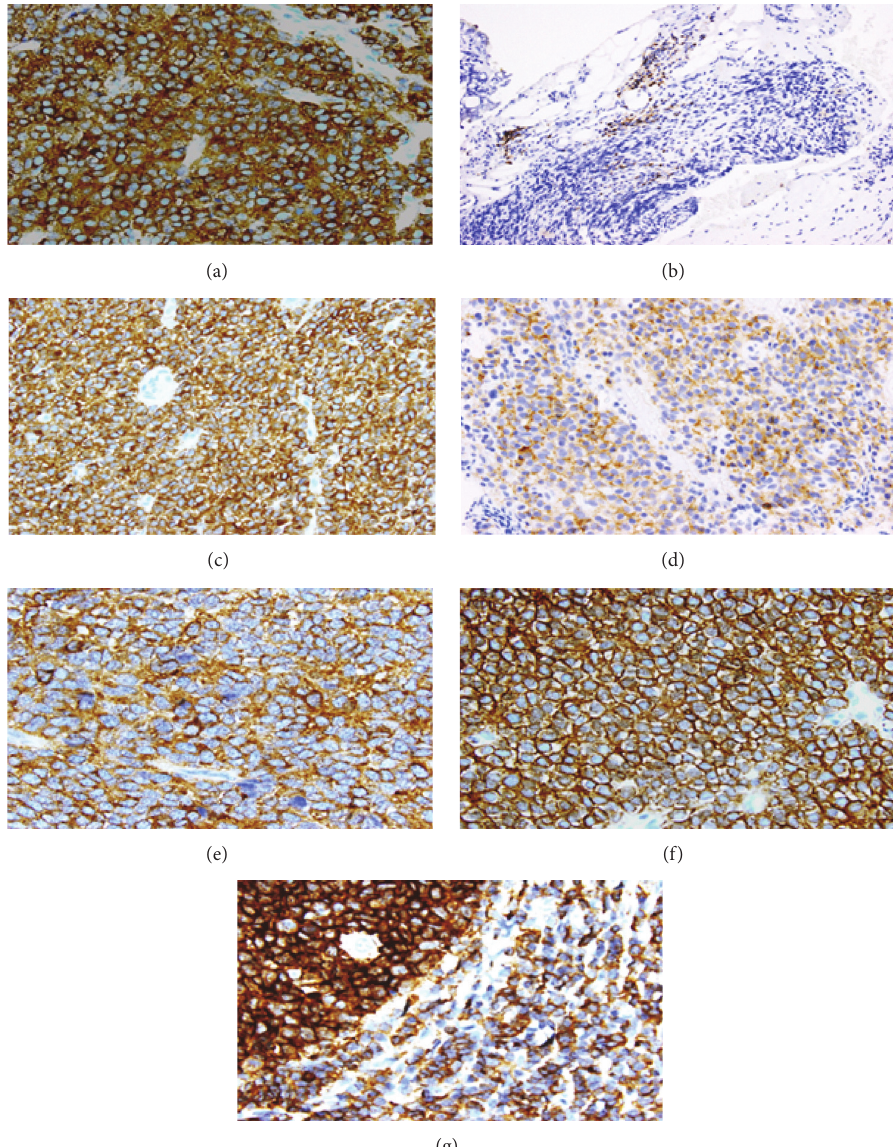
Figure 1: Immunohistochemistry. Ezrin positivity : (a) high and (b) low; Ezrin intensity : (c) high and (d) low; Ezrin expression pattern : (e) cytoplasmic, (f) membranous, and (g)